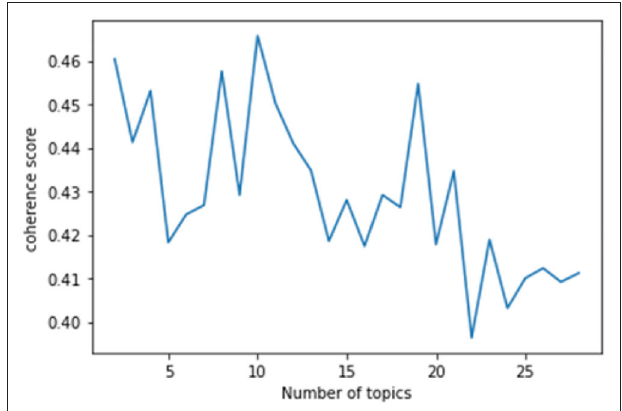
FIGURE 3 | Estimated coherence scores (before the COVID-19 pandemic).